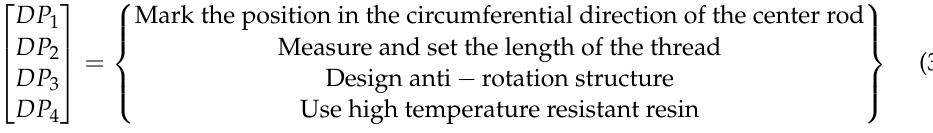
Through the expression of the design parameter vector, the initial conceptual design diagram of the conductive center pole can be obtained, as shown in Figure 10.